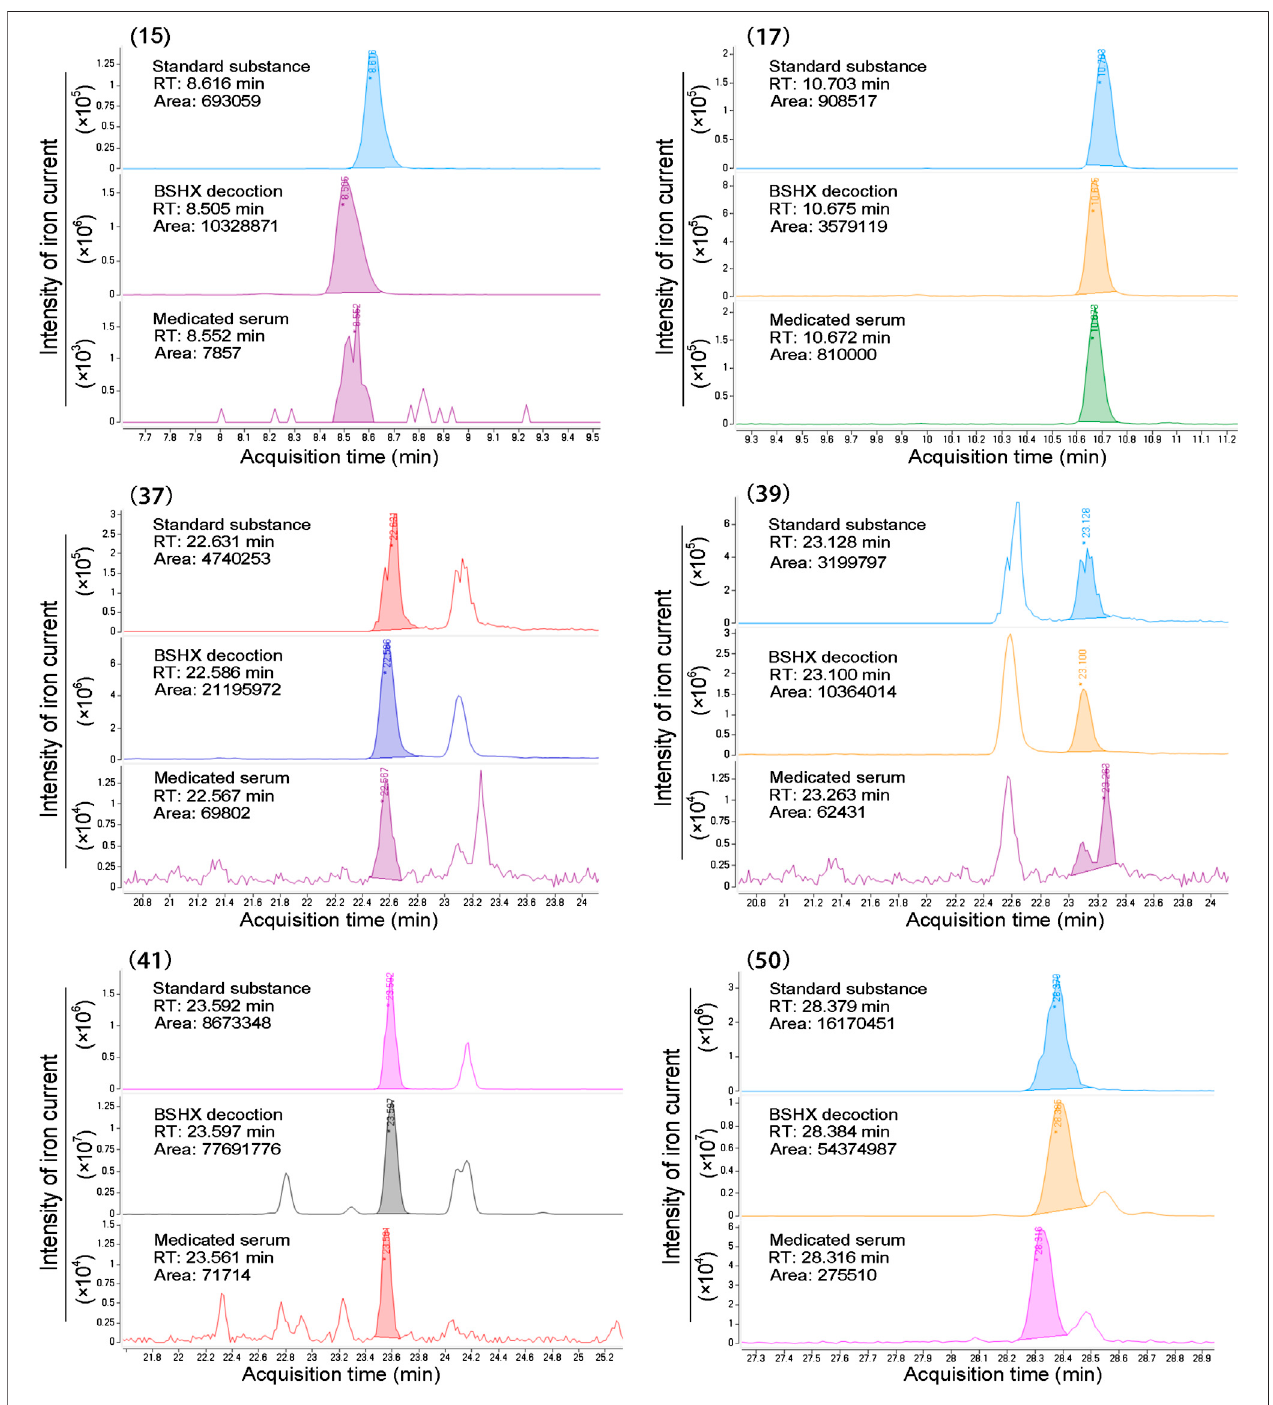
FIGURE 5 | Peak areas information of six compounds determined using standard substances. Standard substance, BSHX decoction, and medicated serum samples peak of six compounds retention time (RT), area, and intensity of ion current, which cohere with the data presented in Table 2 .